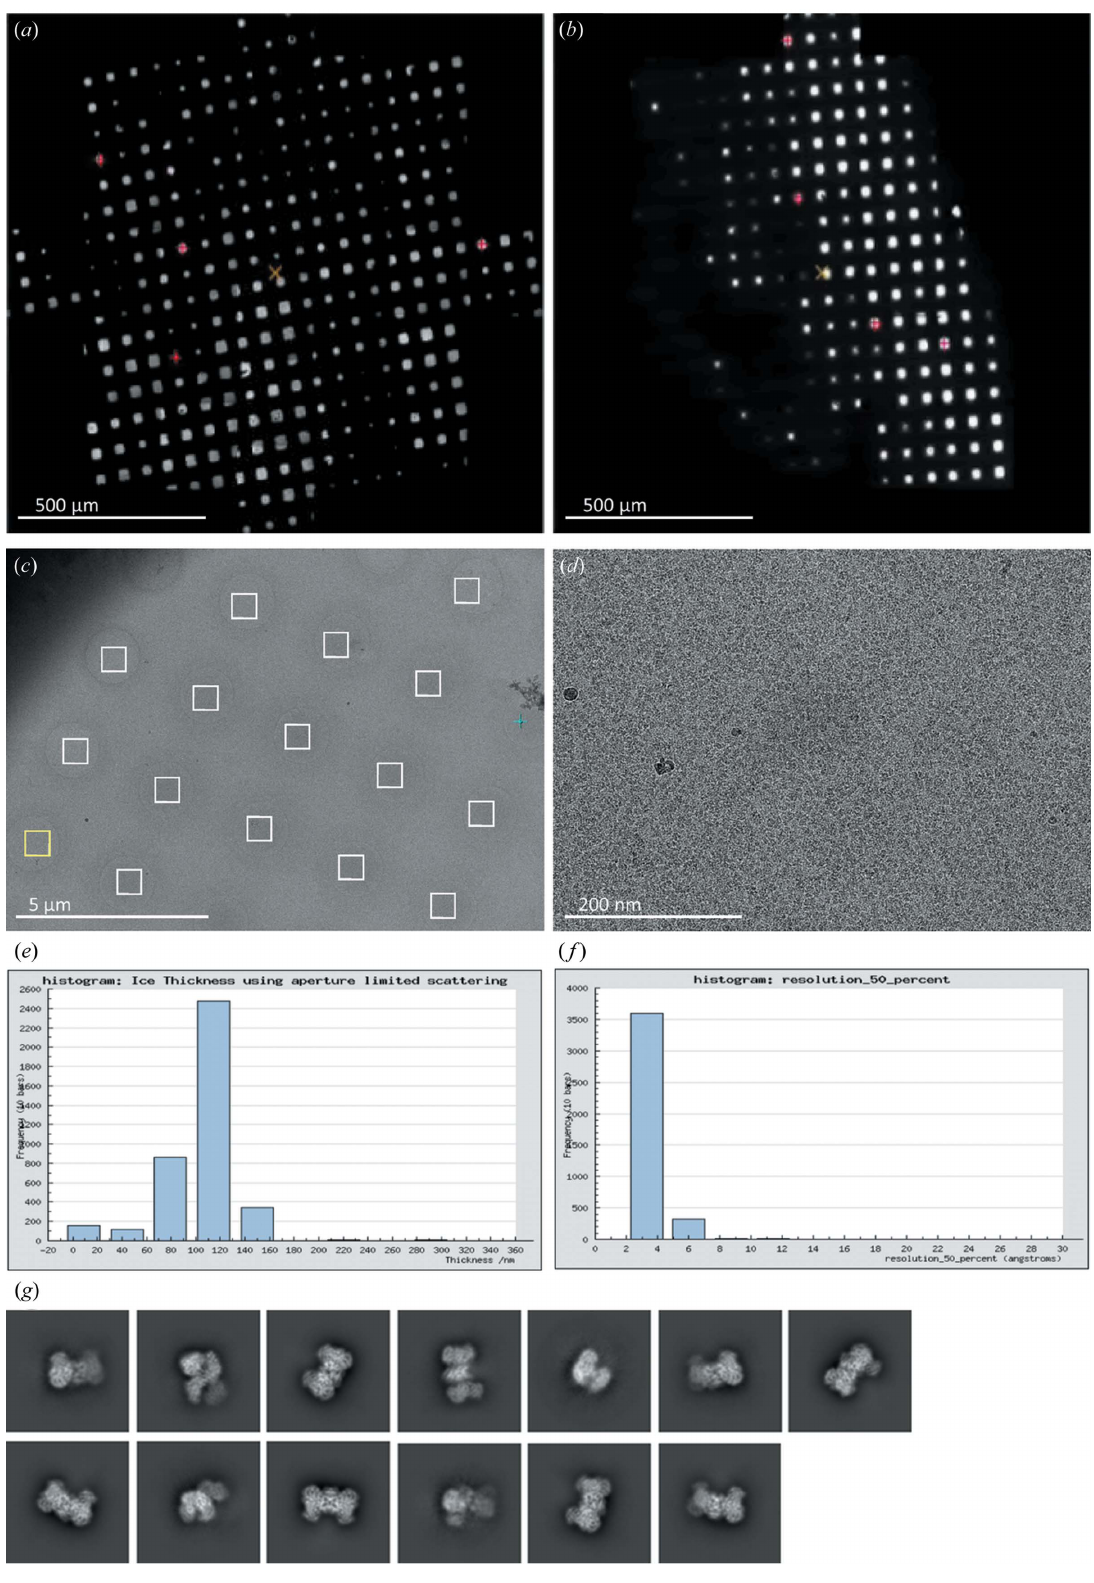
Figure 4 Real-world multi-grid screening with Smart Leginon Autoscreen followed by data collection with the Smart Leginon and the Ptolemy hole finder. Autoscreen readily allowed for the identification of ( a ) the best grid and ( b ) another decent grid. The Ptolemy hole finder from inside Smart Leginon was then used for high-quality data collection from ( c ) the best grid, leading to thousands of ( d ) exposure magnification images in ( e ) areas of moderately thick ice resulting in ( f ) relatively high-resolution CTF estimations, ( g ) high-quality 2D classes and a 3.1 A˚ structure (not